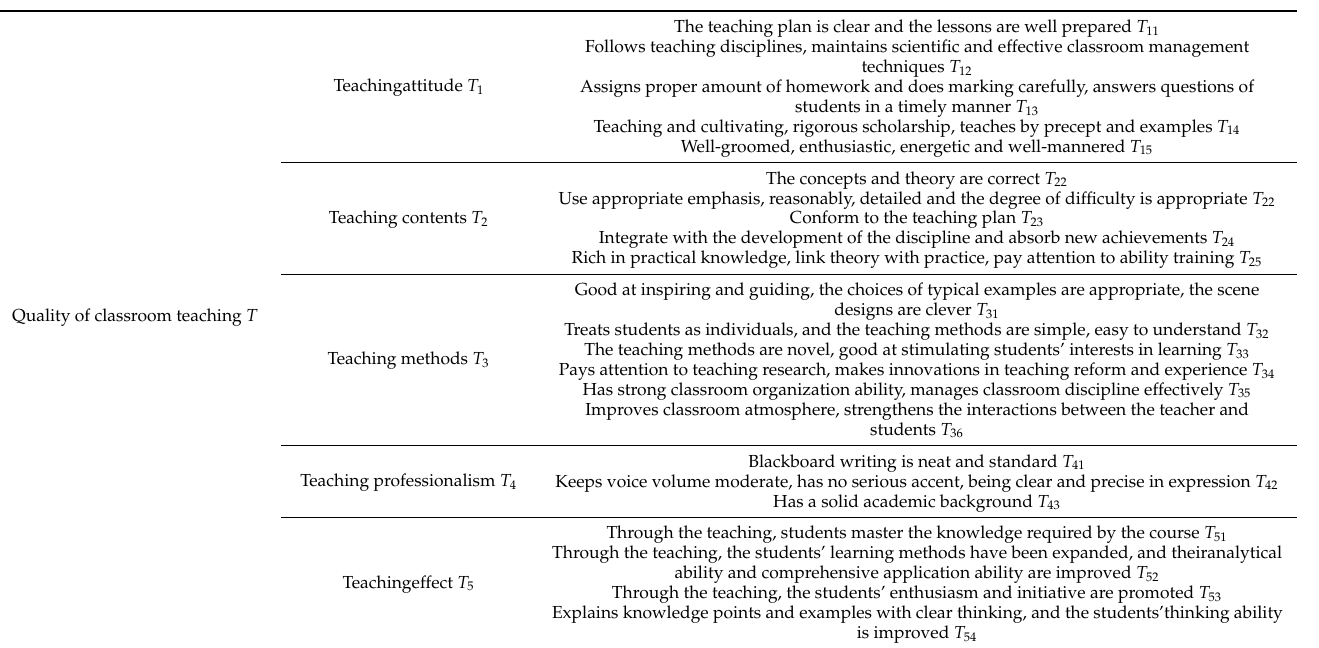
Table 1. University teachers’ teaching performance evaluation indicator